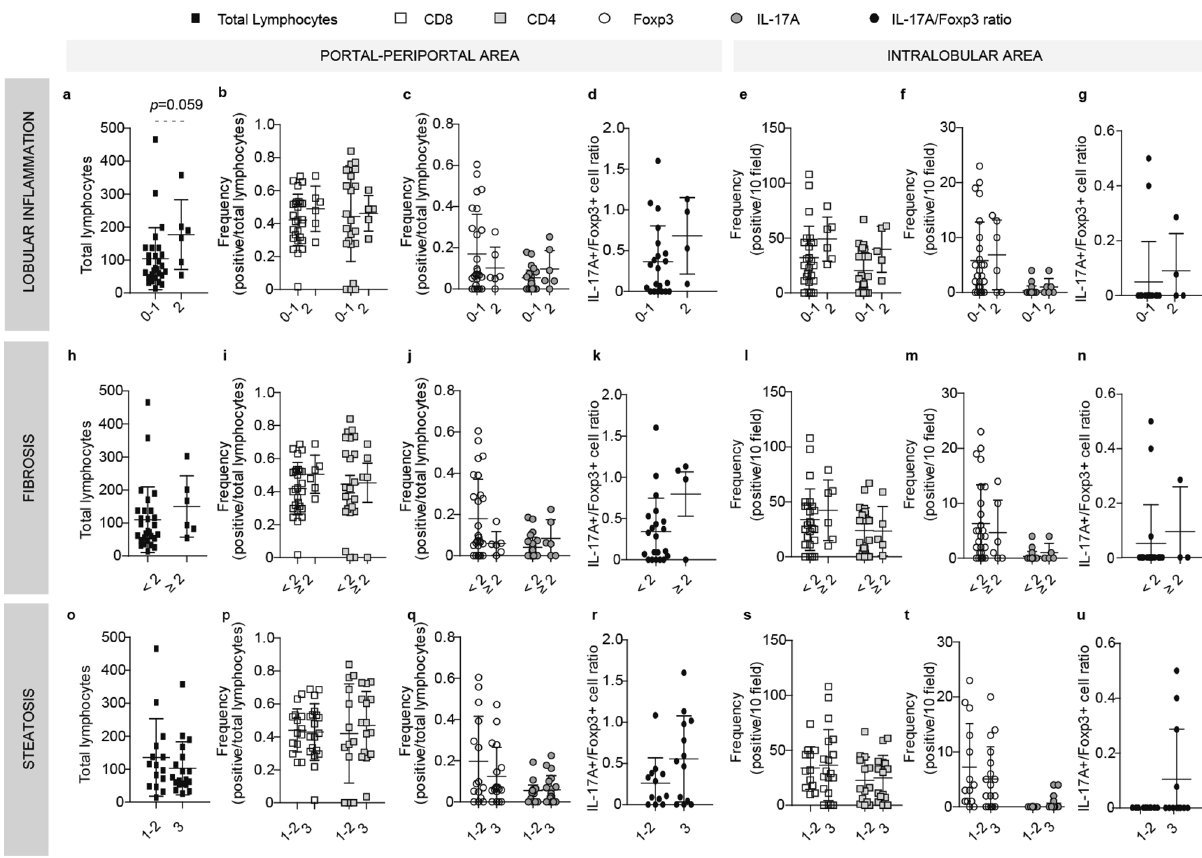
Figure 3. Relationship between intrahepatic infiltrate and liver damage in NAFLD adult cases. Lymphocyte quantification related to lobular inflammation ( a – g ), fibrosis ( h – n ) and steatosis ( o – u ) severity. Total lymphocytes ( a , h , o ), CD8+ and CD4+ ( b , i , p ), Foxp3+ and IL-17A+ cell frequency ( c , j , q ) and IL-17A+ / Foxp3+ cell ratio ( d , k , r ) in portal-periportal area. CD8+ and CD4+ ( e , l , s ), Foxp3+ and IL-17A+ cell frequency ( f , m , t ) and IL-17A+ /Foxp3+ cells ratio ( g , n , u ) in intralobular